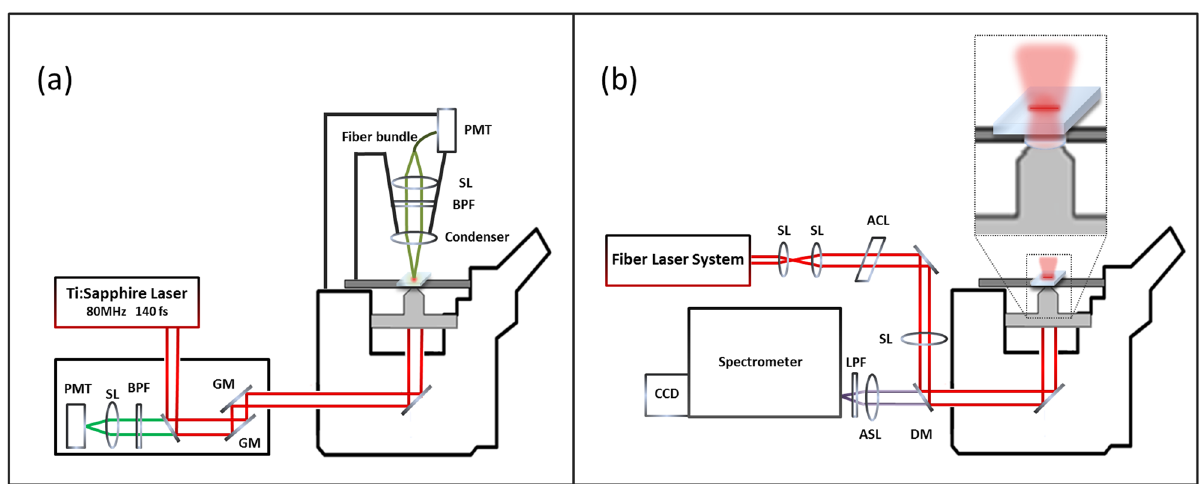
Figure 2. Experimental microscopy systems: ( a ) SHG and 2PAF; ( b ) Hyperspectral Raman. ACL achromatic cylindrical lens, ASL achromatic spherical sens, BPF bandpass filter, DM dichroic mirror, GM galvomirror, LPF longpass filter, PMT photomultiplier tube, SL spherical